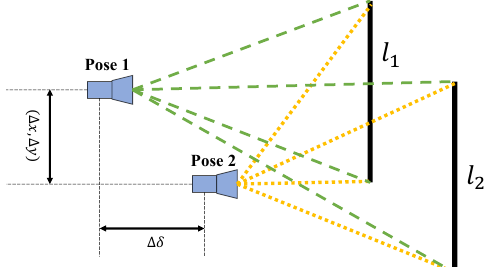
Figure 7. Objects of different depths in the FoV of the camera. When the camera moves from Pose 1 to Pose 2, the pixel motions of l 1 and l 2 are inversely proportional to the